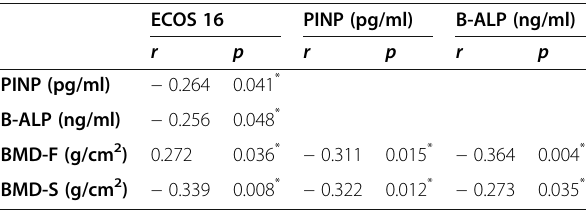
Table 3 Correlation between different parameters in osteoporosis group (n=60) ECOS 16 PINP (pg/ml) B-ALP (ng/ml) r p r p r p PINP (pg/ml) − 0.264 0.041 * B-ALP (ng/ml) − 0.256 0.048 * BMD-F (g/cm 2 ) 0.272